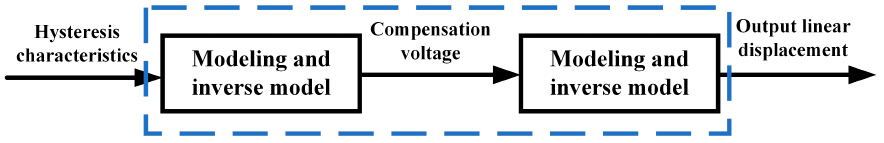
13 of 22 Figure 12. Voltage–hysteresis tangent slope plots: ( a ) cycle 1 v-s(v) plot; ( b ) cycle 1 slope data sep- aration plot. ( a ) ( b ) Figure 13. Voltage–hysteresis tangent slope plots: ( a ) new second cycle v-s(v) plot; ( b ) new second cycle slope data separation plot. Figures 12 and 13 illustrate the relationship between different voltages and corre- sponding slopes, which can either display an upward or a downward trend. In Figure 12b, Cycle 1 Separation Point 1 and Cycle 1 Separation Point 2 are the inflection points of the slope change of the voltage-hysteresis tangent line for the first cycle data. This inflec- tion point is used as the separation point for the data separation process. In Figure 13b, Cycle 2 Separation Point 1 and Cycle 2 Separation Point 2 are the inflection points of the slope change of the voltage-hysteresis tangent line for the new second cycle data. This inflection point is used as the separation point for the data separation process.